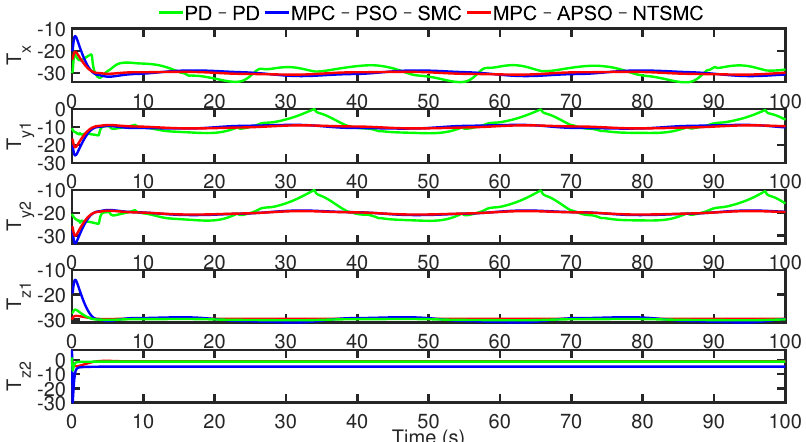
Figure 19. The thrust of thrusters for the tracking task with wave and current disturbance for Case